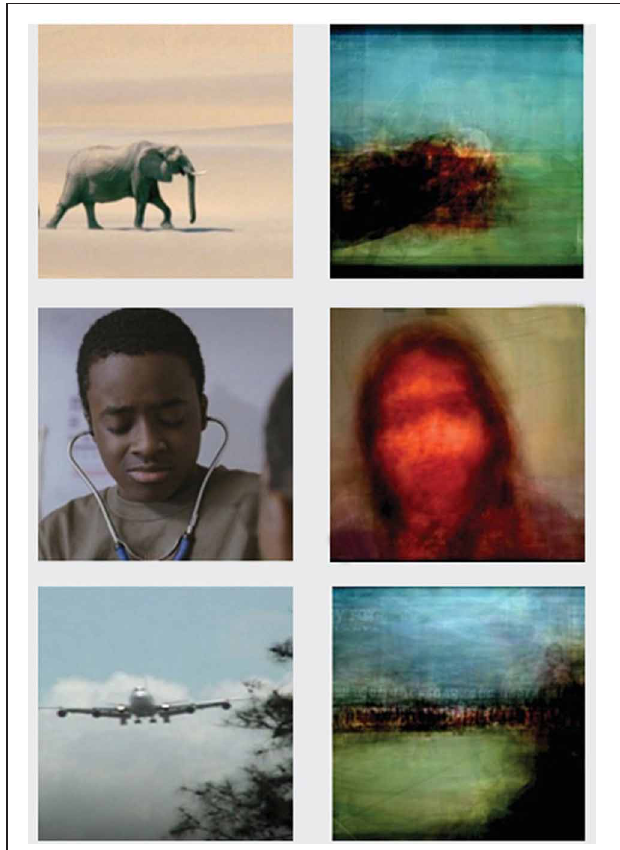
FIGURE 2 | On the left: visual experience from natural movies. On the right: reconstruction of these images by decoding brain activity. Adapted from movie S1 published in Current Biology, 21, Nishimoto, S., Vu, A. T., Naselaris, T., Benjamini, Y., Yu, B., and Gallant, J. L. “Reconstructing visual experiences from brain activity evoked by natural movies.” Supplementary Information. Copyright: Elsevier 2011. Figure approved by corresponding author Jack